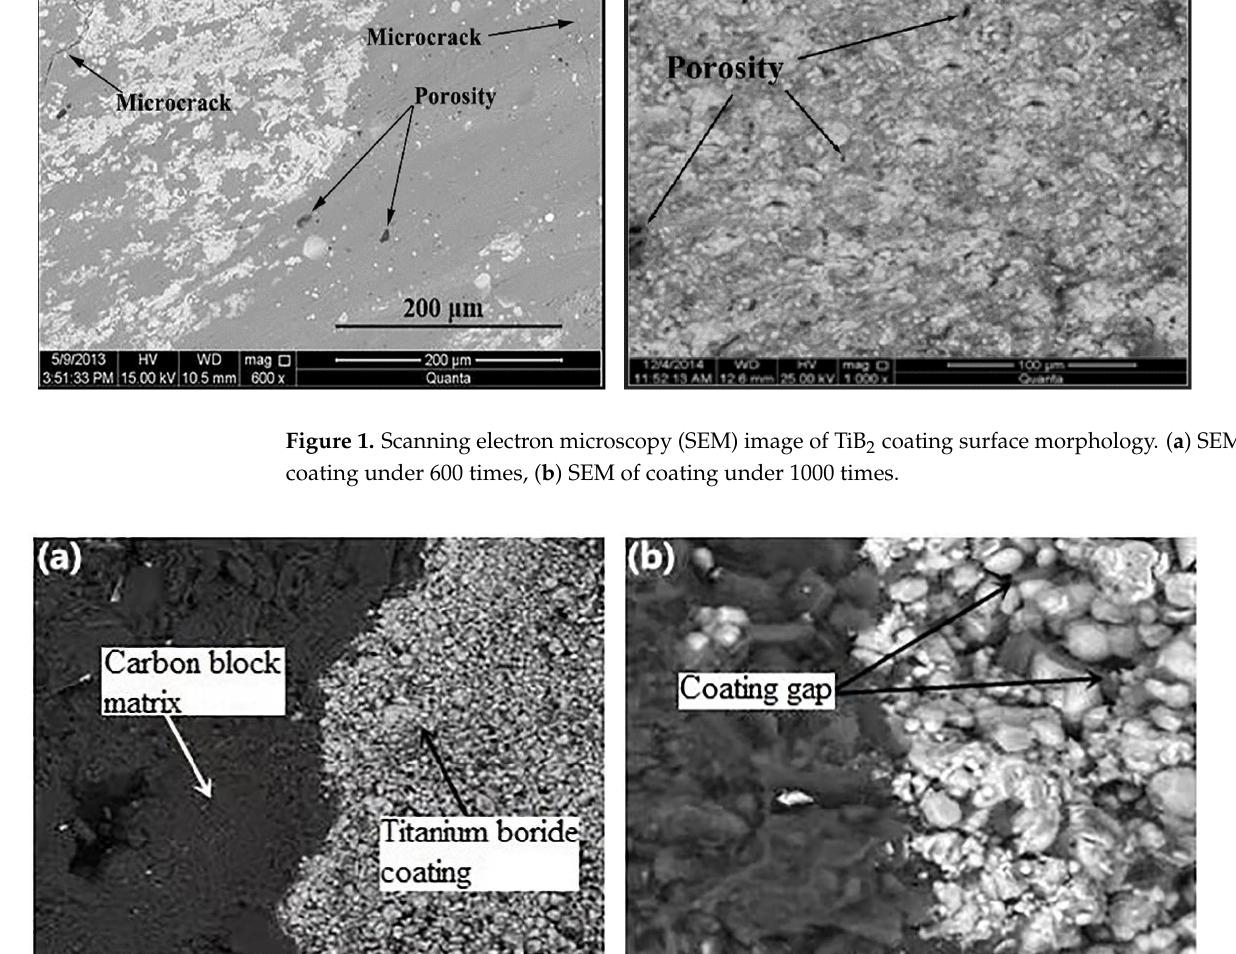
Figure 2. TiB 2 coatings sectional SEM micrographs. ( a ) SEM of coating under 600 times, ( b ) SEM of coating under 1000 times.